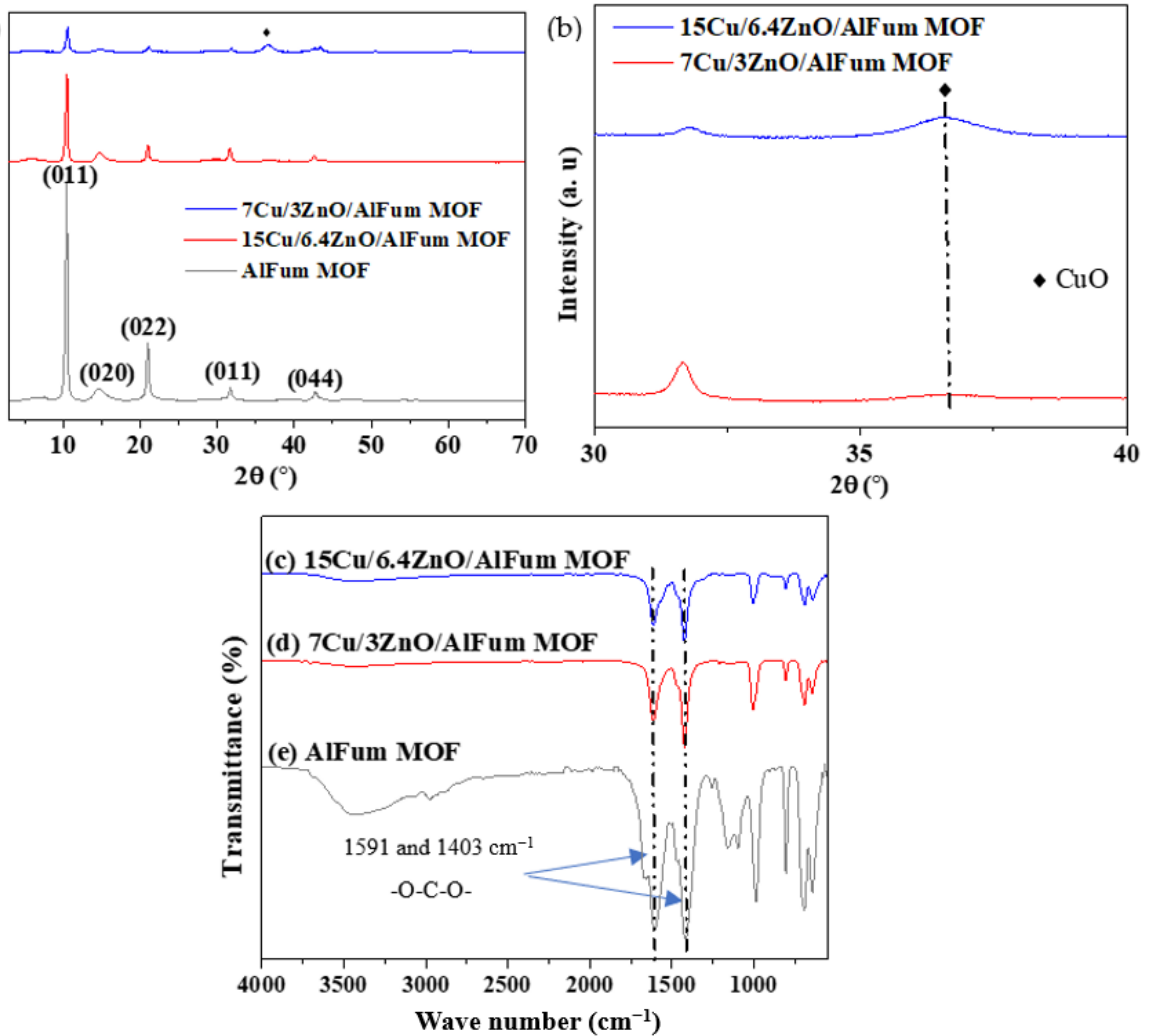
Figure 1. PXRD patterns of ( a ) AlFum MOF, 7Cu/3ZnO/AlFum MOF, 15Cu/6.4ZnO/AlFum MOF; ( b ) 7Cu/3ZnO/AlFum MOF, 15Cu/6.4ZnO/AlFum MOF at 30° < 2θ < 40°; and ( c – e ) FTIR spectra of AlFum MOF, 7Cu/3ZnO/AlFum MOF, and 15Cu/6.4ZnO/AlFum MOF. CuO ( ♦ ).